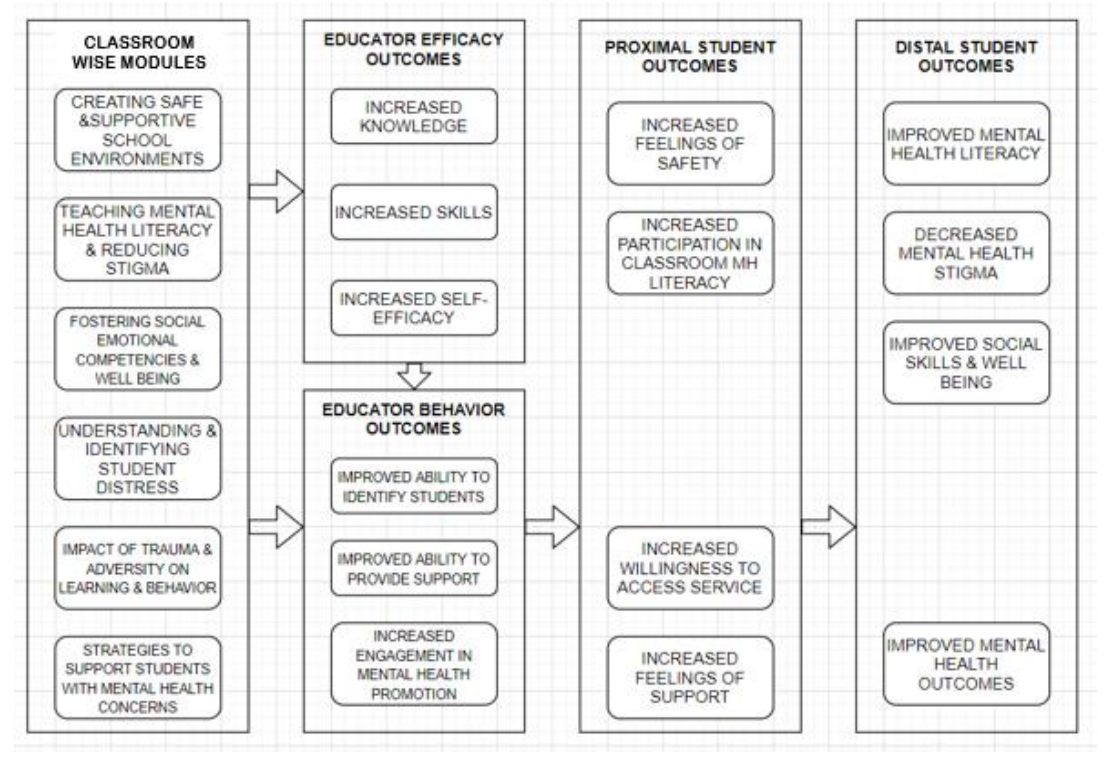
Figure 3. Educator mental health literacy professional development logic model .